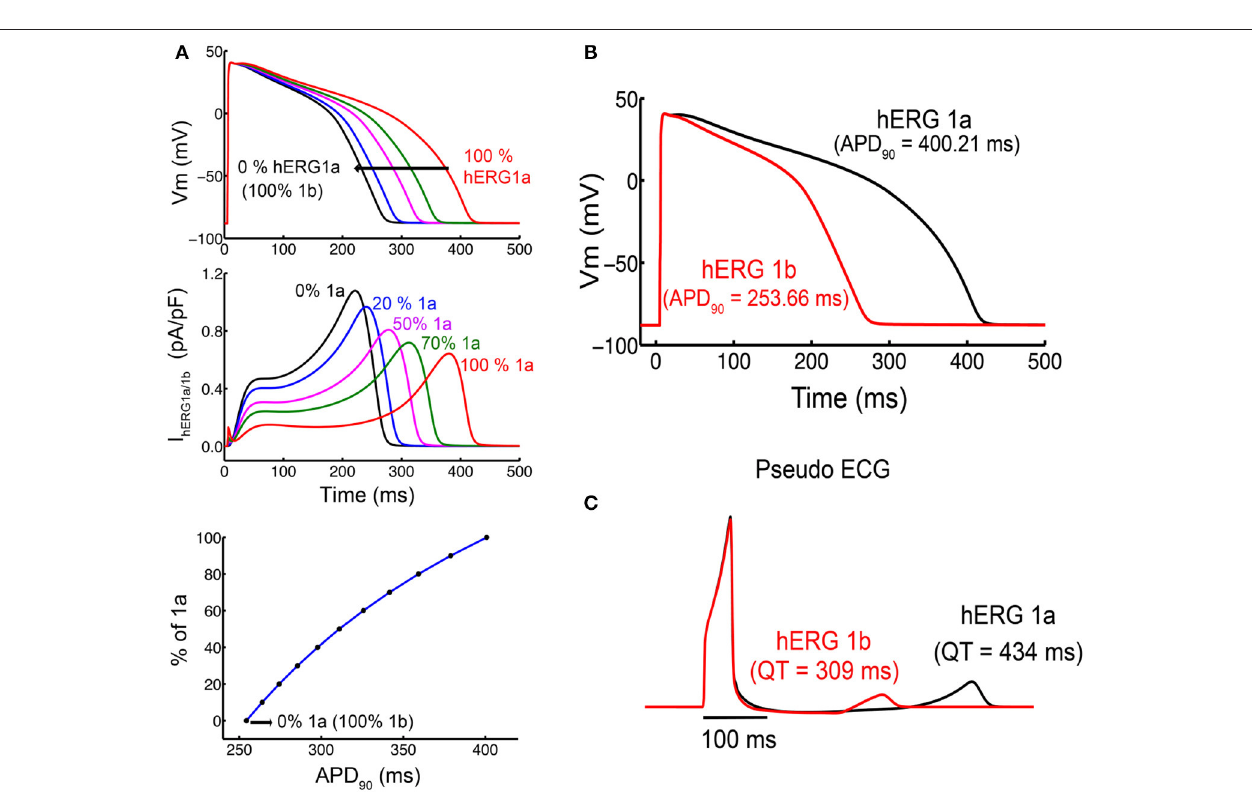
FIGURE 12 | Simulated action potential duration (APD) in cells and virtual pseudo-ECGs in a transmural 1-D tissue model. (A) Single cells simulations show concentration response for different ratios of a- and b-isoforms. (B) APD for the 1,000th paced beat at 1Hz in single endocardial cells. hERG 1a shows a longer APD compared to hERG 1b. (C) The Pseudo ECGs of hERG 1b (red) indicates shorter QT intervals than hERG